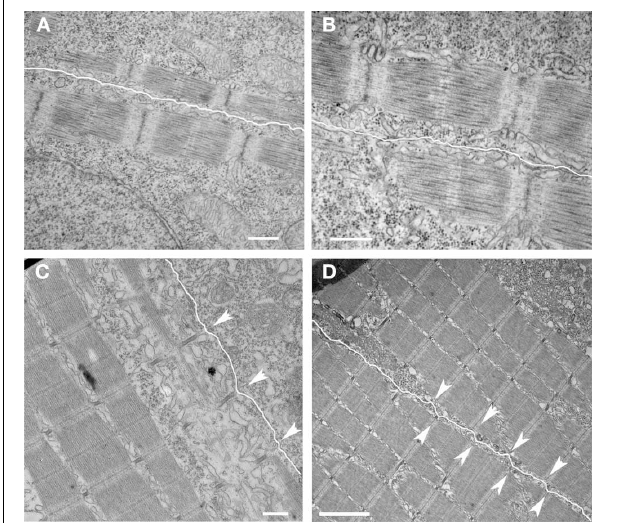
FIGURE 4 | Development of nascent costameres. Skeletal muscle from zebrafish embryos at 20hpf (A,B) demonstrate a consistent offset in the alignment of the Z disks across adjacent myocytes (sarcolemma highlighted in white). Note that the distance from the myofibril to the membrane is consistent over the length of the myofibril. By 72hpf (C,D) , the membrane hasamoreundulated appearanceandisclosesttothemyofibril overlyingthe Z disks (arrowheads) consistent with the maturation of costameric connections from the myofibril to the sarcolemma. Scale bars are 500nm (A–C) and 2 μ m (D) .